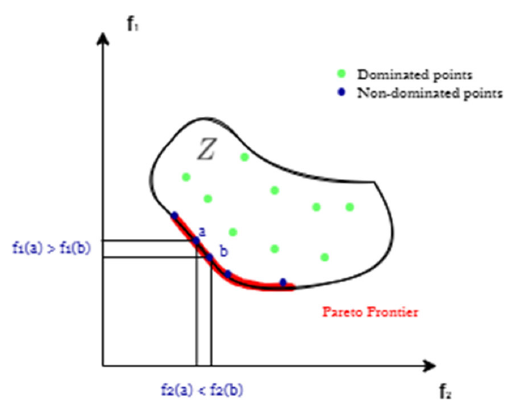
Fig. 2. Pareto Front illustration. Adapted from Miettinen